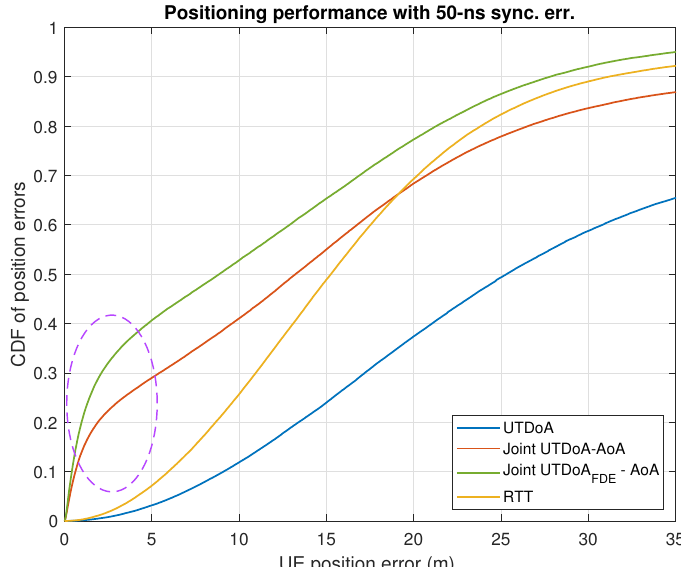
Figure 5. Results for 20 MHz bandwidth with 50 ns sync. err.